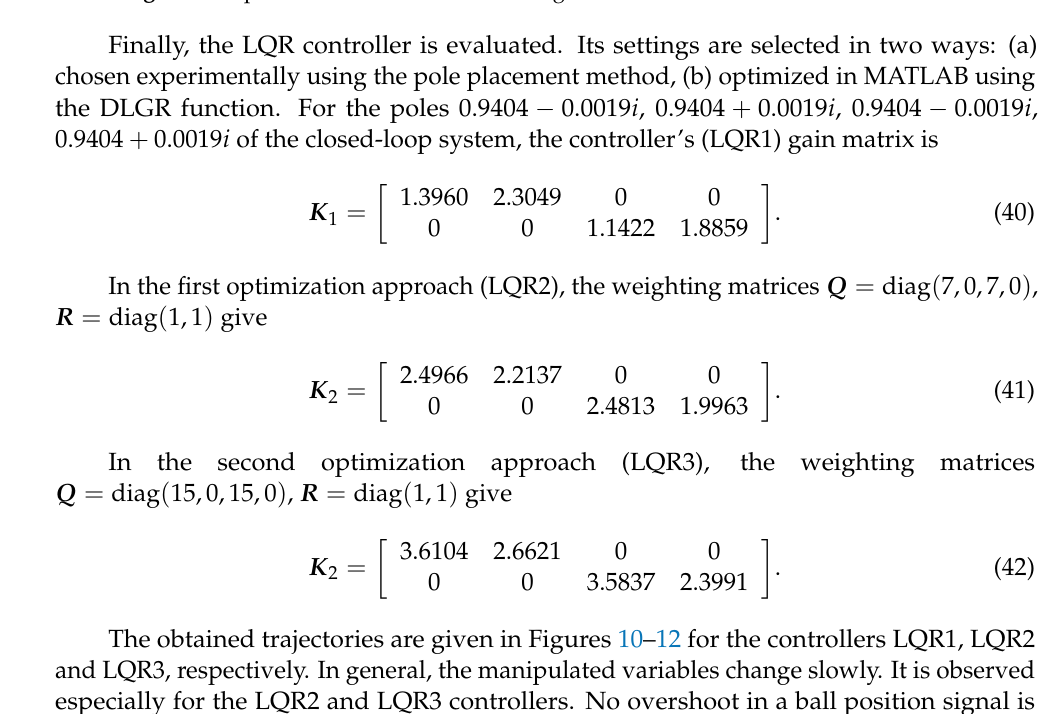
Figure 9. Experimental results of the PID